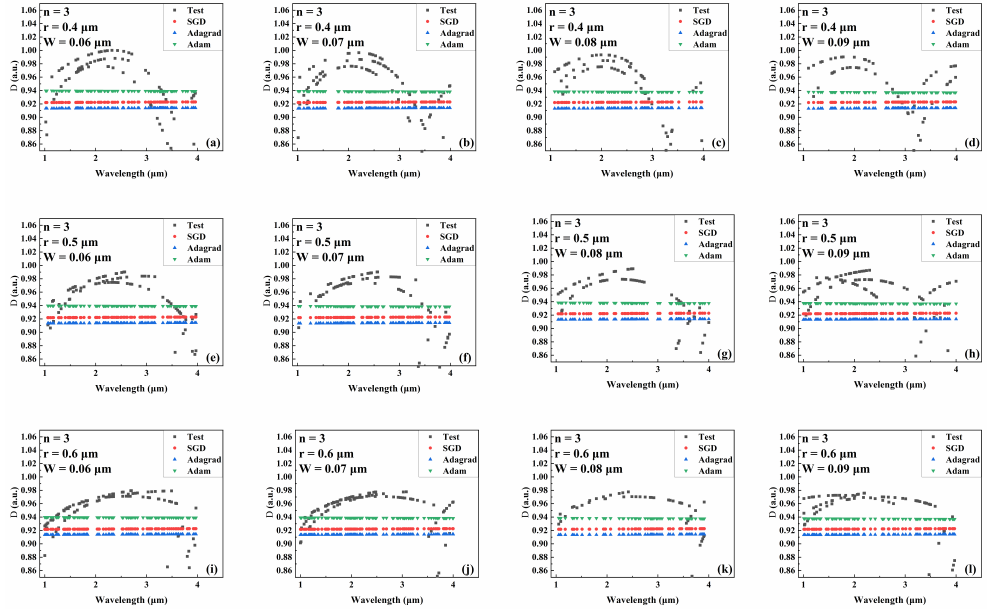
Figure 12. Comparison the predicted and actual values of D in the test data set of the network model trained by different optimizers for different combinations of core radius and cantilever width (number of cantilevers: 3). ( a ) r = 0.4 µ m, W = 0.06 µ m. ( b ) r = 0.4 µ m, W = 0.07 µ m. ( c ) r = 0.4 µ m, W = 0.08 µ m. ( d ) r = 0.4 µ m, W = 0.09 µ m. ( e ) r = 0.5 µ m, W = 0.06 µ m. ( f ) r = 0.5 µ m, W = 0.07 µ m. ( g ) r = 0.5 µ m, W = 0.08 µ m. ( h ) r = 0.5 µ m, W = 0.09 µ m. ( i ) r = 0.6 µ m, W = 0.06 µ m. ( j ) r = 0.6 µ m, W = 0.07 µ m. ( k ) r = 0.6 µ m, W = 0.08 µ m. ( l ) r = 0.6 µ m, W = 0.09 µ m.